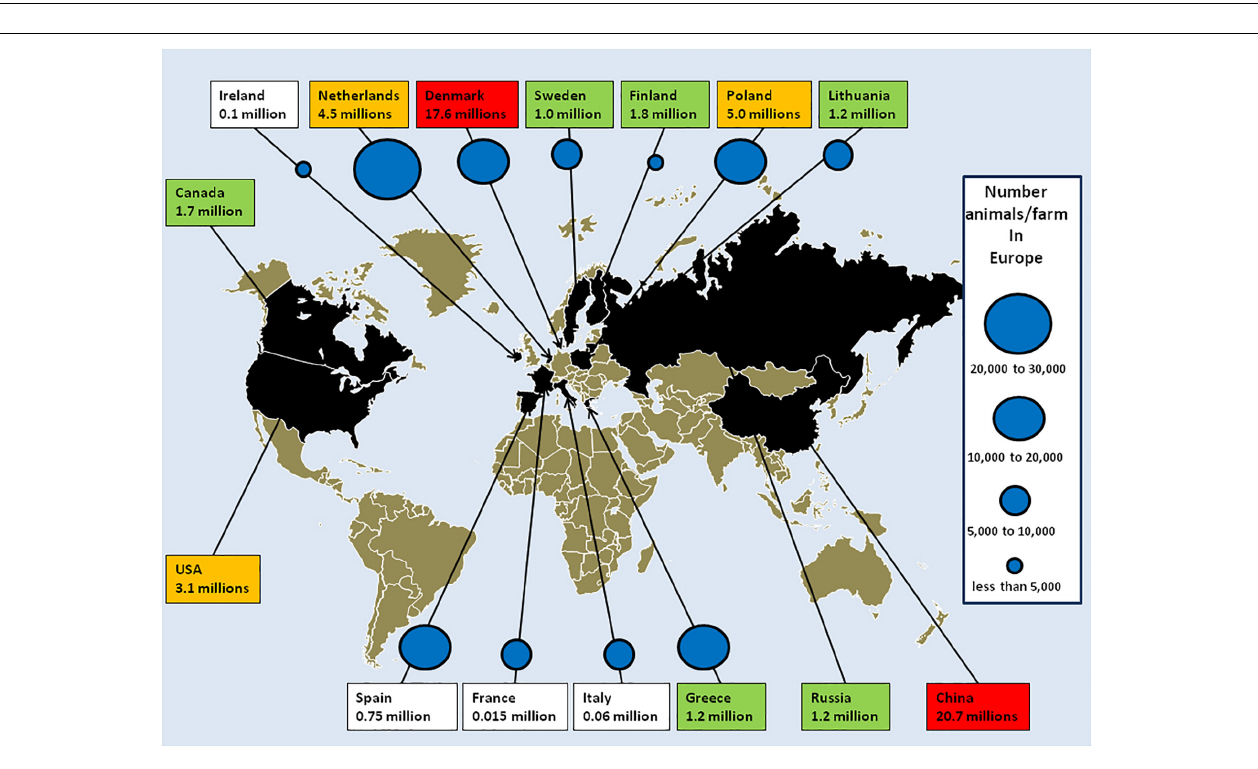
FIGURE 2 | The mink fur industry. Mink stocks according to reports from the European Commission (ECDC, 2020), the fur industry (Fur Europe, 2015) and associations. China, Denmark, Poland, and Netherlands were the main producers. Red box: 10–21 million minks/year; orange: 2–10 million minks/year; green: 1–2 million minks/year; and white: below 1 million. Mass culling of minks ordered by governments after SARS-CoV-2 outbreaks in mink farms in Europe: Denmark: 17,000,000; Netherlands: 900,000; Ireland: 100,000; Spain: 92,700; Italy: 28,000; Greece: 2,500; and France: 1,000. The number of mink farms in Europe [adapted from a report from the ECDC (2020)] is indicated by blue circles (it is possible to estimate the risk of cross contamination in mink farms as a function of the density of animal populations). Fur-farming ban (year): United Kingdom 2000; Austria 2004; Croatia 2006; Serbia 2009; Slovenia and New Zealand 2013; Japan 2016; Macedonia 2017; Luxembourg, the Czech Republic and Norway 2018; and Germany and Slovakia 2019. Scheduled shutdown of mink farms: Belgium and Denmark 2023; Netherlands: 2024 (early closure 2021); France: 2025; and Bosnia and Herzegovina 2027. Outside Europe, in China in 2018 farms were mainly concentrated in the northern provinces (Shandong, Liaoning, Heilongjiang, Jilin, and Henan), and produced 20.7 million minks. In North American, 245 farms produced 3.1 million pelts in the United States and 60 farms in Canada produced 1.7 million pelt. In Russia, 22 farms produced 1.2 million minks.